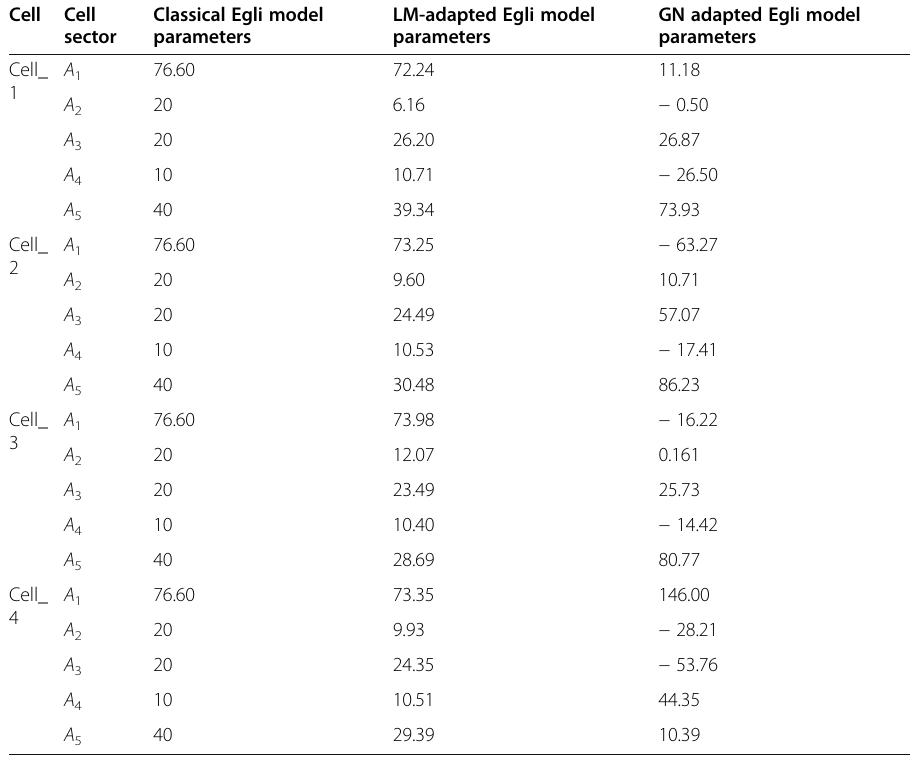
Table 2 Estimated coefficients and statistics for Cell_1 to Cell_4 Cell Cell